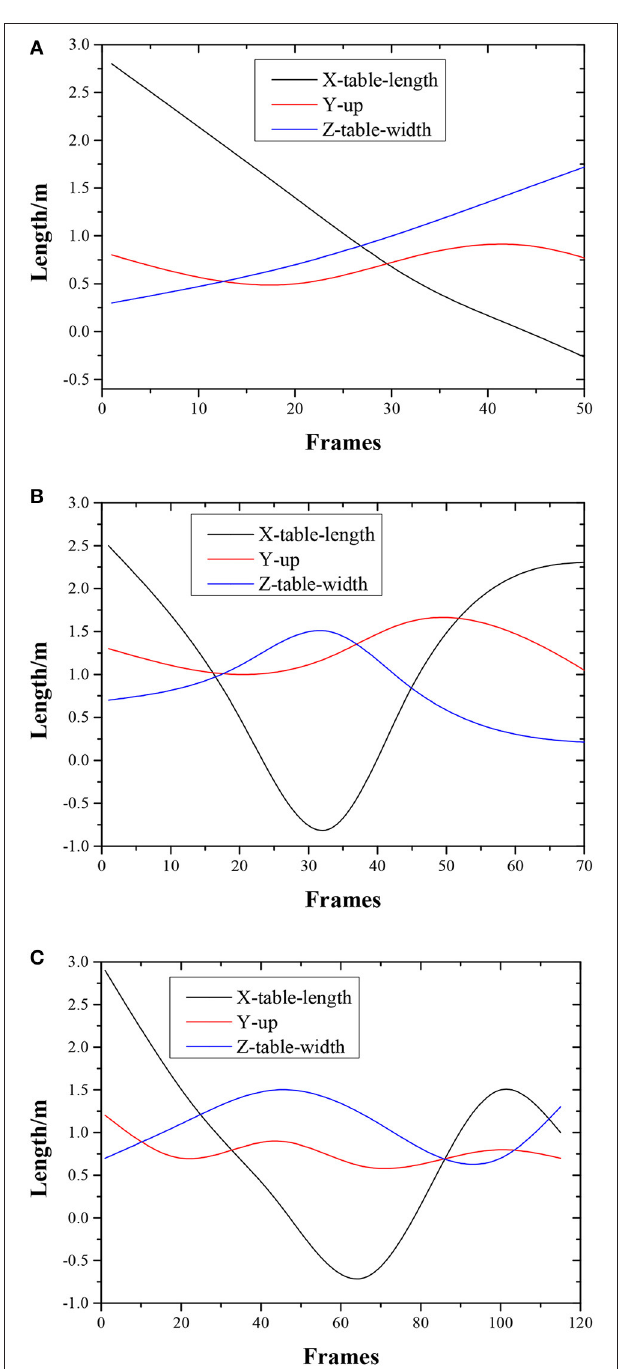
to the evaluation of the motions corresponding to a particular hitting round. In the experiment, the analysis results of the ball trajectory and the right arm extension motion of athletes in the same round are shown in Figure 11 . The black curve, red curve, and blue curve in the trajectory diagram represent the position changes in the table tennis along the long side, vertical upward, and short side of the table, respectively. The lower side shows the change graph of the shoulder joint extension angle in the unit of the angle at